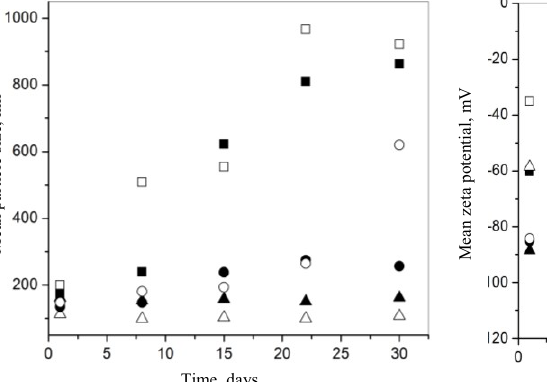
Figure 5. Mean particle size at pH 7.5 (■, □), 8.5 (▲, △ ) and 9 (●, ○) of linolenate -linolenic acid vesicle (filled symbol) and PEGylated linolenate-linolenic acid vesicle (empty symbol).